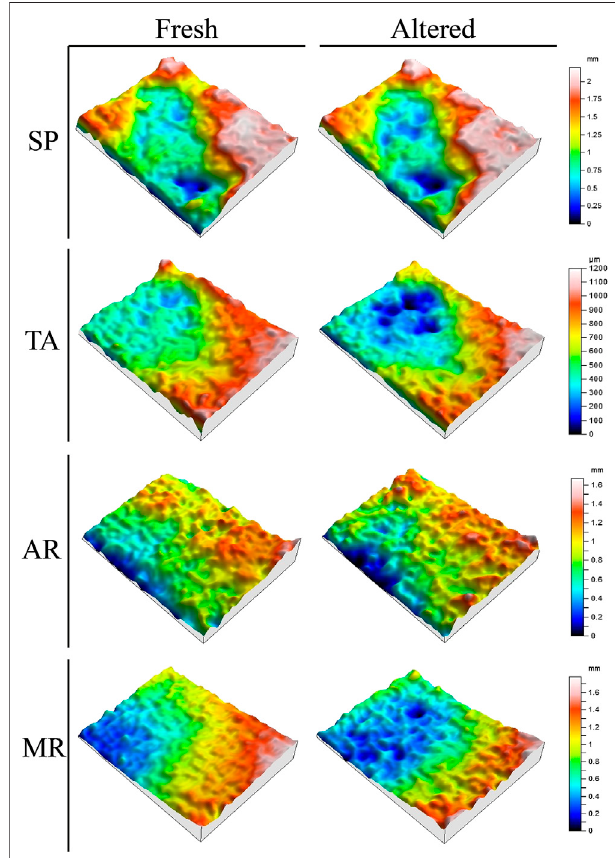
FIGURE 8 | Most representative topographic maps of roughness in 3D (bush-hammered fi nish, BH) in Calcarenita de Santa Pudia (SP), Travertino Amarillo (TA), Arenisca Ronda (AR) and Molinaza Roja (MR). The difference shown here (in mm or in µm) is between fresh samples (Fresh) and altered samples after removing the gypsum crust